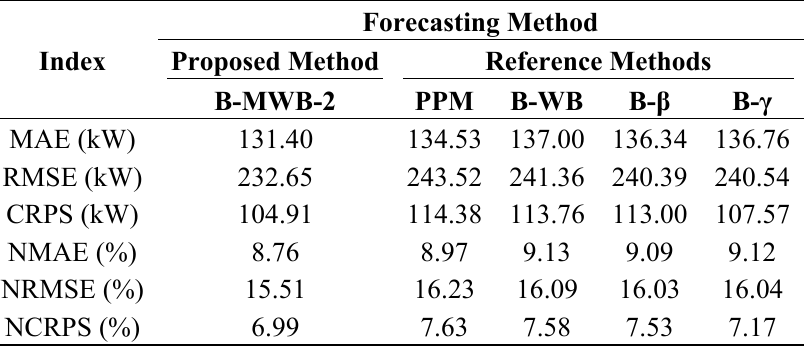
Table 5. Time-series TS2: Values of absolute and percentage indices for the forecasts averaged from 1 October 2013 to 31 October 2013.